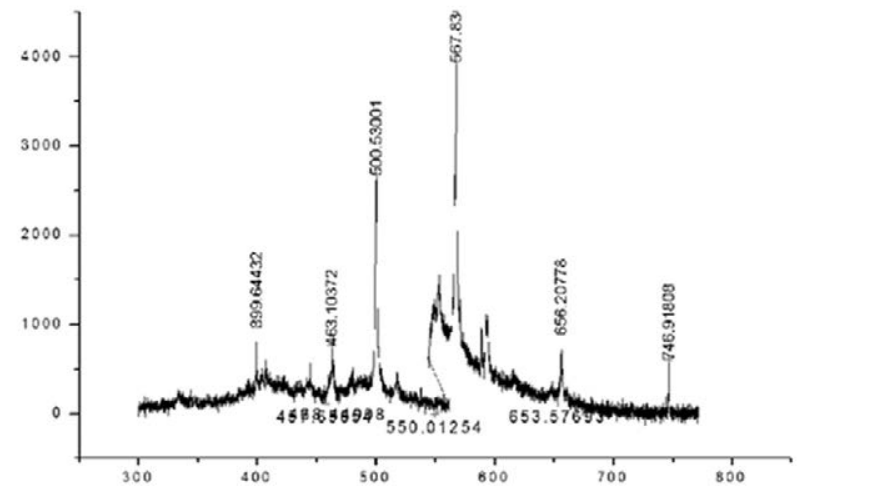
Fig. 1. Laser Induced Breakdown Spectroscopy (LIBS) spectra of crude A. modesta